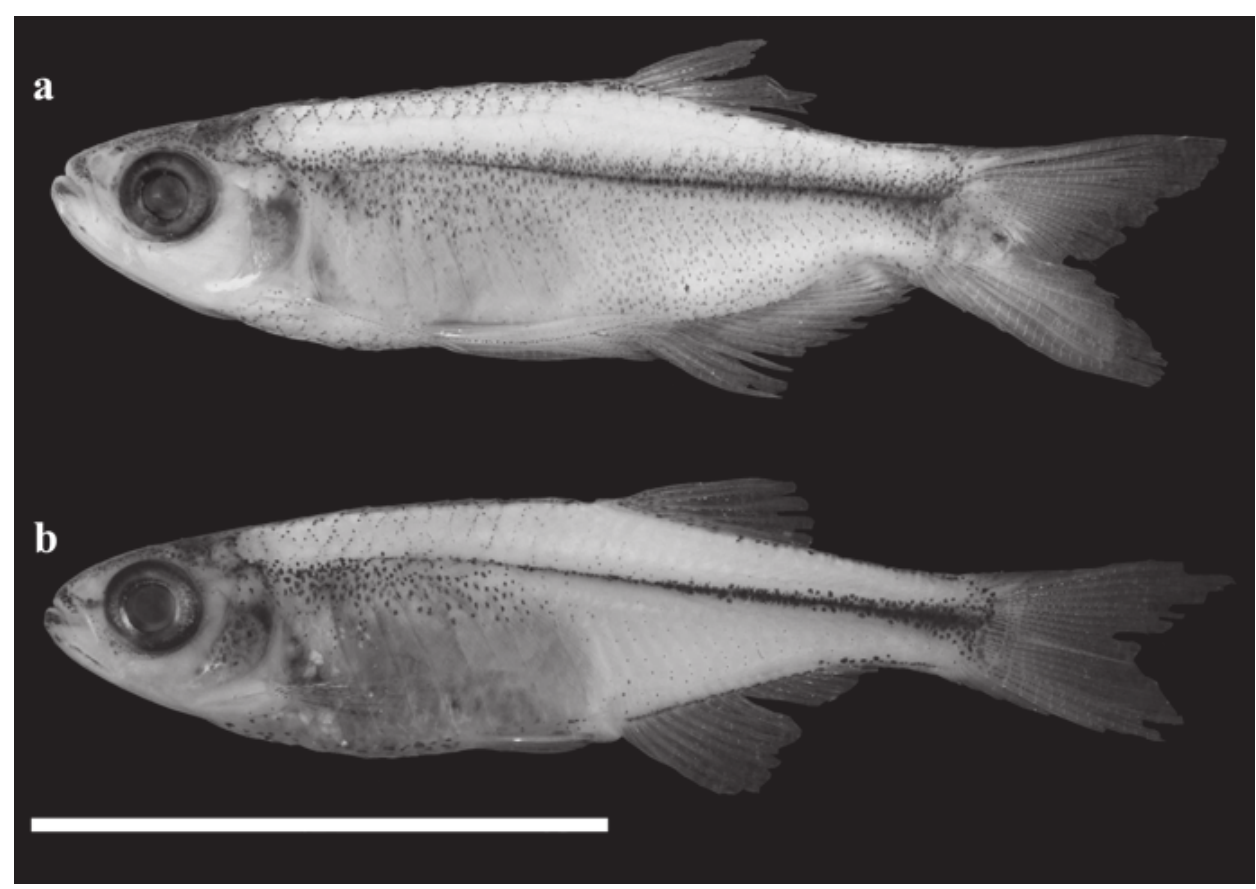
Fig. 1. Tyttocharax metae , Colombia, Meta. a) holotype, IUQ 2581, adult male, 15.3 mm SL; b) paratype, IUQ 2343; adult female, 15.5 mm SL. Scale bar = 1 cm. Color in life. Dorsum of body, head and post ventral area greenish yellow, with an evident absence of dark pigment. Sides of body with blue stripe, caused by presence of iridophores that generate an iridescent bluish aspect known as Rayleigh scattering. The iridophores are limited on